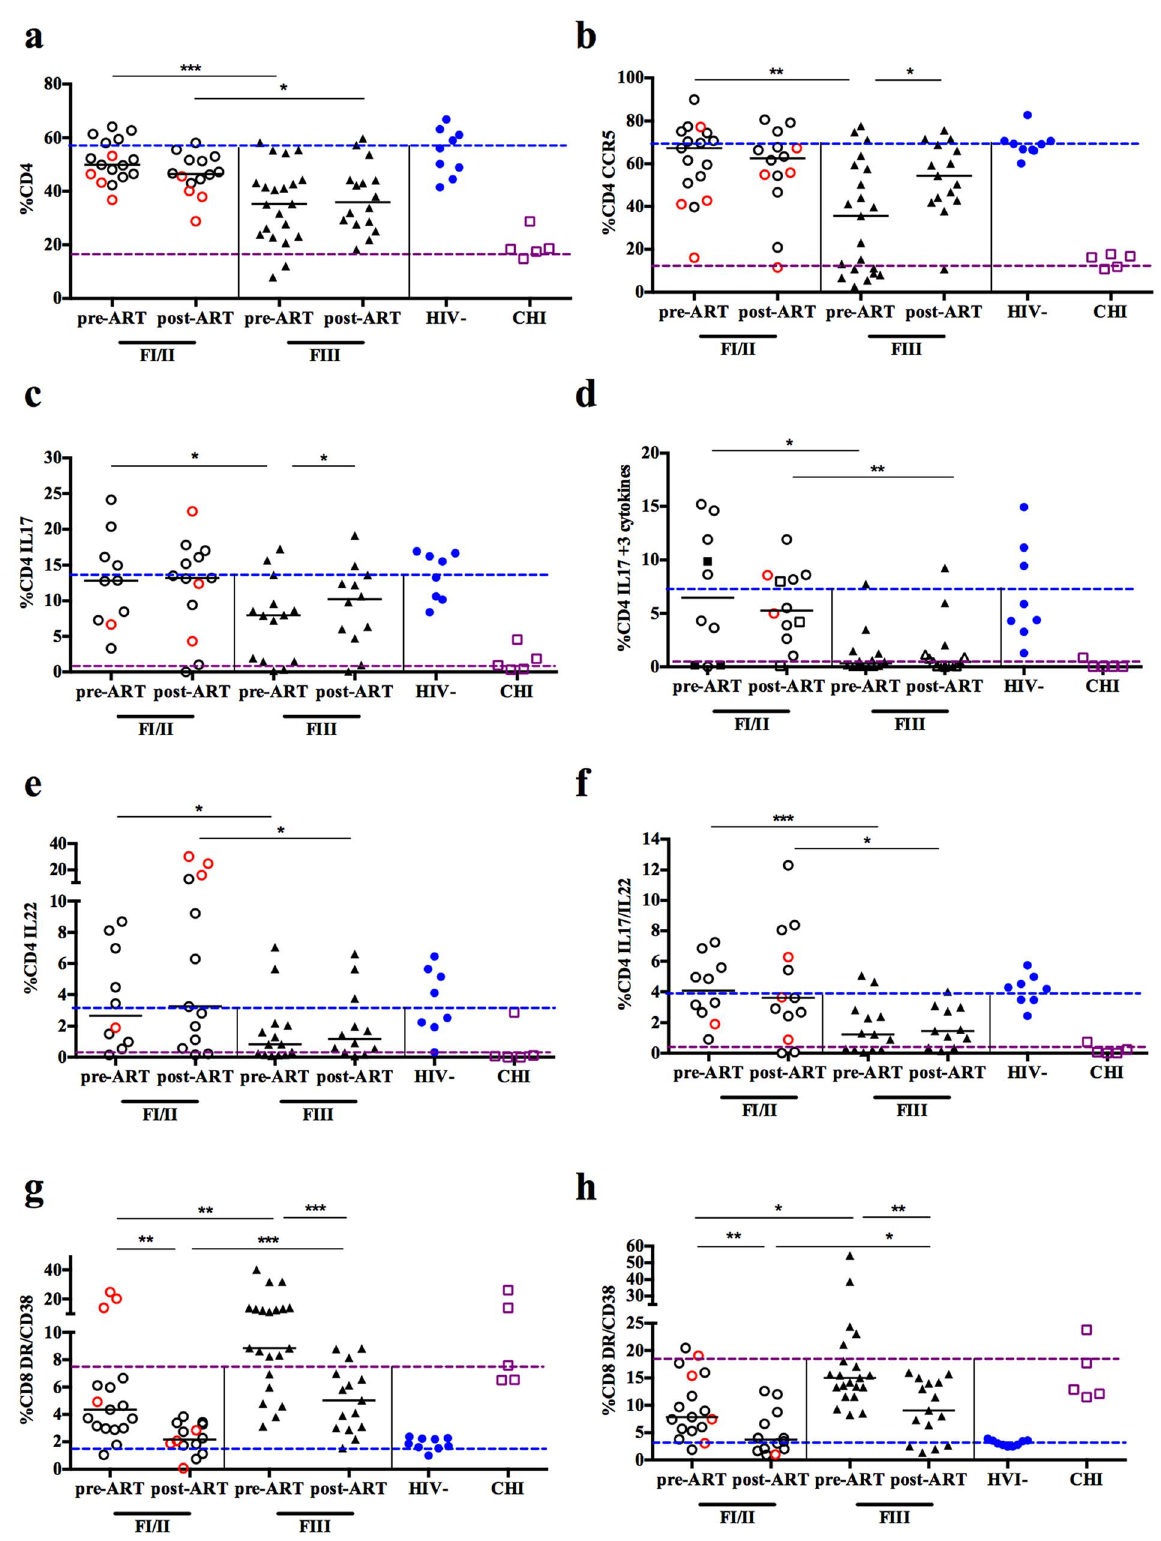
Fig. 3. Impact of early ART initiation on CD4 + and CD8 + T cells as well as Th17 cells. Subjects that initiated ART during FI (black circle)/FII (red circle) for 6 months were able to maintain mucosal CD4 + T cells ( a ), CD4 + CCR5 + ( b ), Th17 cells ( c ), triple cytokine-producing Th17 cells ( d ), Th22 cells ( e ), and IL-17 and/or IL-22 ( f ) producing CD4 + T cells with no differences when compared to HIV-. In addition their CD8 activation in the mucosa ( g ) and periphery ( h ) normalized after 6 months of ART. Frequency of single and double cytokine producing cells was calculated from percentage CD4 + T cells, while triple-cytokine producing cells were calculated from percentage of CD4 + IL17 + T cells. *p # 0.05, **p # 0.01 and ***p # 0.001; DR: HLA-DR; blue dotted line: median of HIV- individuals; purple dotted line: median of CHI individuals. doi:10.1371/journal.ppat.1004543.g003 PLOS Pathogens |